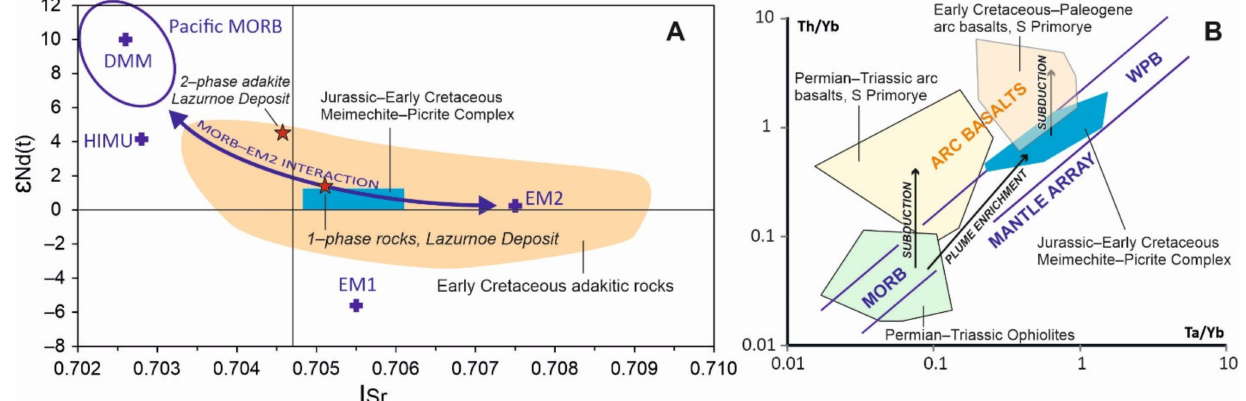
Figure 6. Isotopic-geochemical evidence of interaction between mantle plume and subduction in the Sea-of-Japan region (simplified from [23]). ( A ) Sr-Nd isotopic compositions of the Jurassic–Early Cretaceous mafic-ultramafic and adakitic rocks (after [18]) with addition from [31] for rocks of the Lazurnoe porphyry Cu-Mo (+Au, Ag) deposit. ( B ) Th/Yb versus Ta/Yb (after [32]) in the late Paleozoic–Early Cenozoic mafic rocks. The MORB, Mid-Ocean Ridge Basalt; DMM, Depleted Mantle Member; WPB, Within-Plate Basalt; HIMU, EM1, and EM2, enriched mantle sources [33].